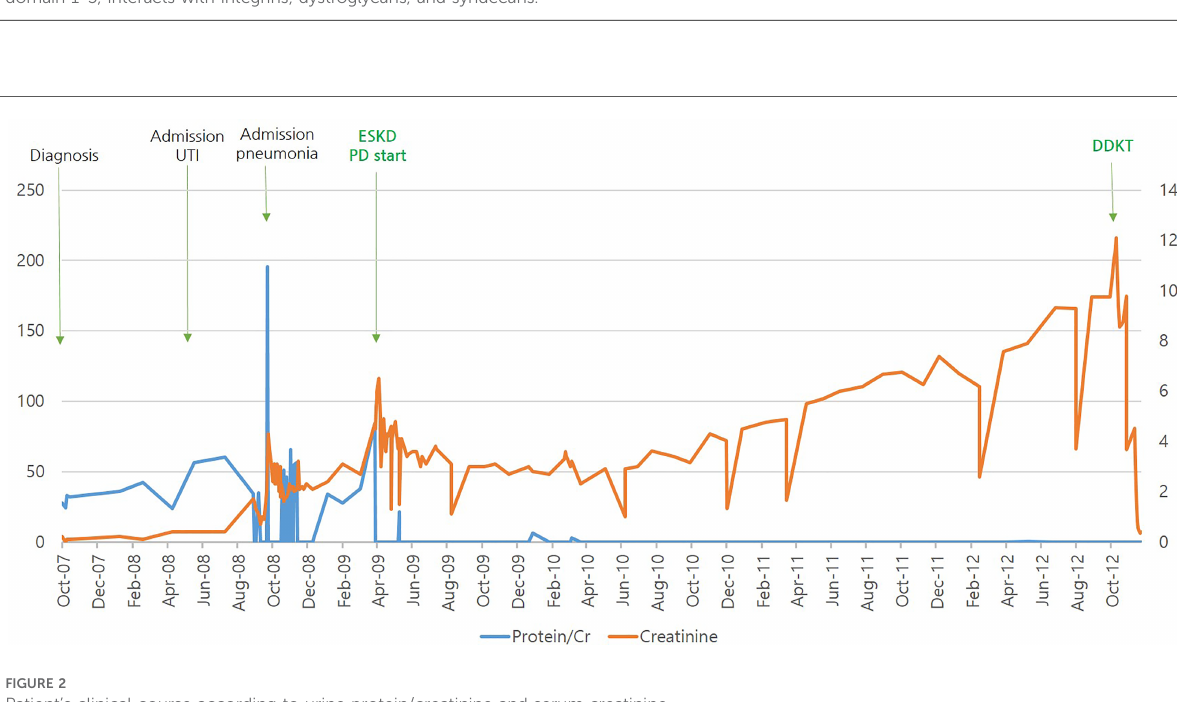
FIGURE 1 Structure of laminin α 5, modi fi ed from Taniguchi Y, and localization of reported variants; LN=Laminin-N-terminal; mediates trimer polymerization LEa,b,c=Laminin-Epidermal Growth Factor-like domain a,b,c; L4a,b=laminin domain 4 a,b; LCC=long coiled-coil domain LG 1-5=laminin globular domain 1-5, interacts with integrins, dystroglycans, and syndecans.